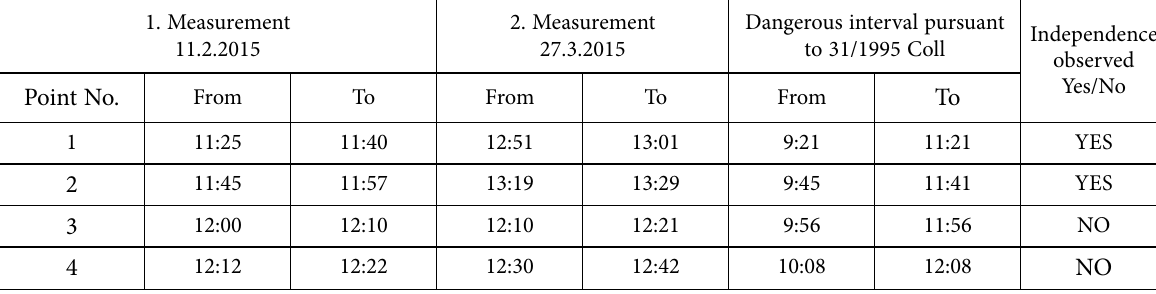
Table 1. Observation times and intervals unsuitable for repetitive measurement